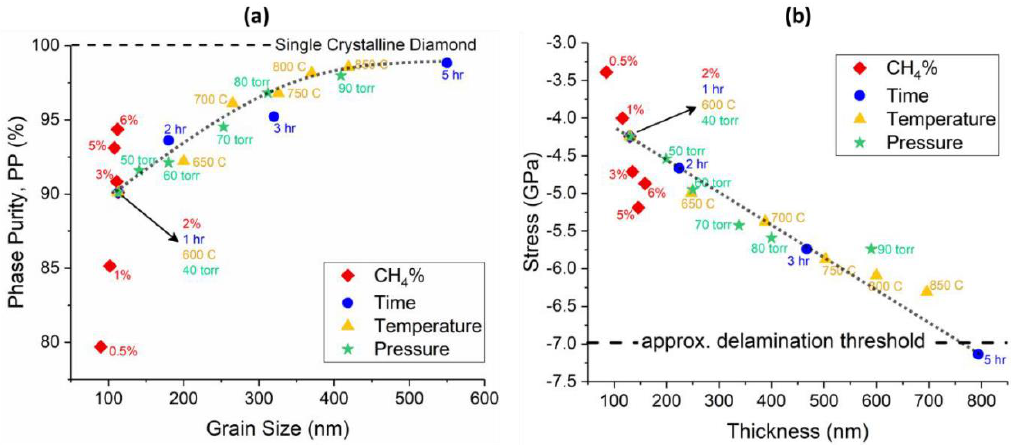
Figure 8. Characteristics of the diamond layer with different growth parameters. ( a ) Phase purity versus grain size of the diamond layer. ( b ) Residual stress as a function of film thickness [98].